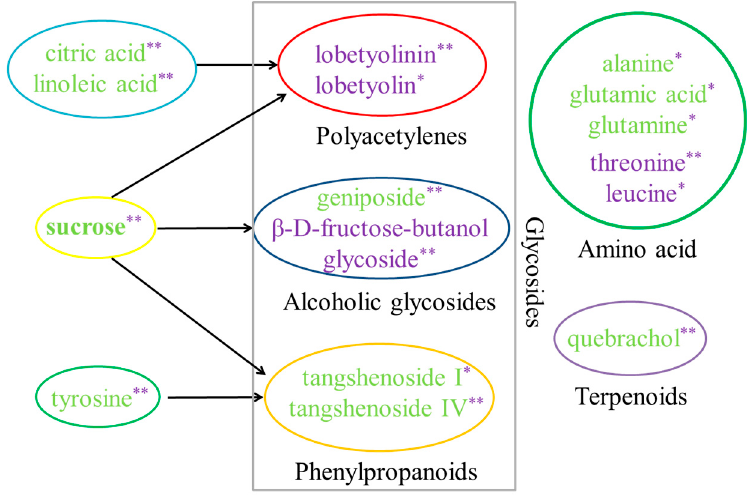
Figure 8. Biomarkers identified in the MeJA treated adventitious root of C. pilosula . The differential analysis of the compound level was analyzed using the t -test. Purple font indicated up regulation. Green font indicated down regulation. Black arrow indicated the relationship between the precursor and metabolite. Aqua circle, fatty acid; Red circle, polyacetylenes; Green circle, amino acids; Blue circle, glycosides; Yellow circle, carbohydrates; Orange circle, phenylpropanoids; Purple circle, terpenoids. * indicated p < 0.05. ** indicated p < 0.01.